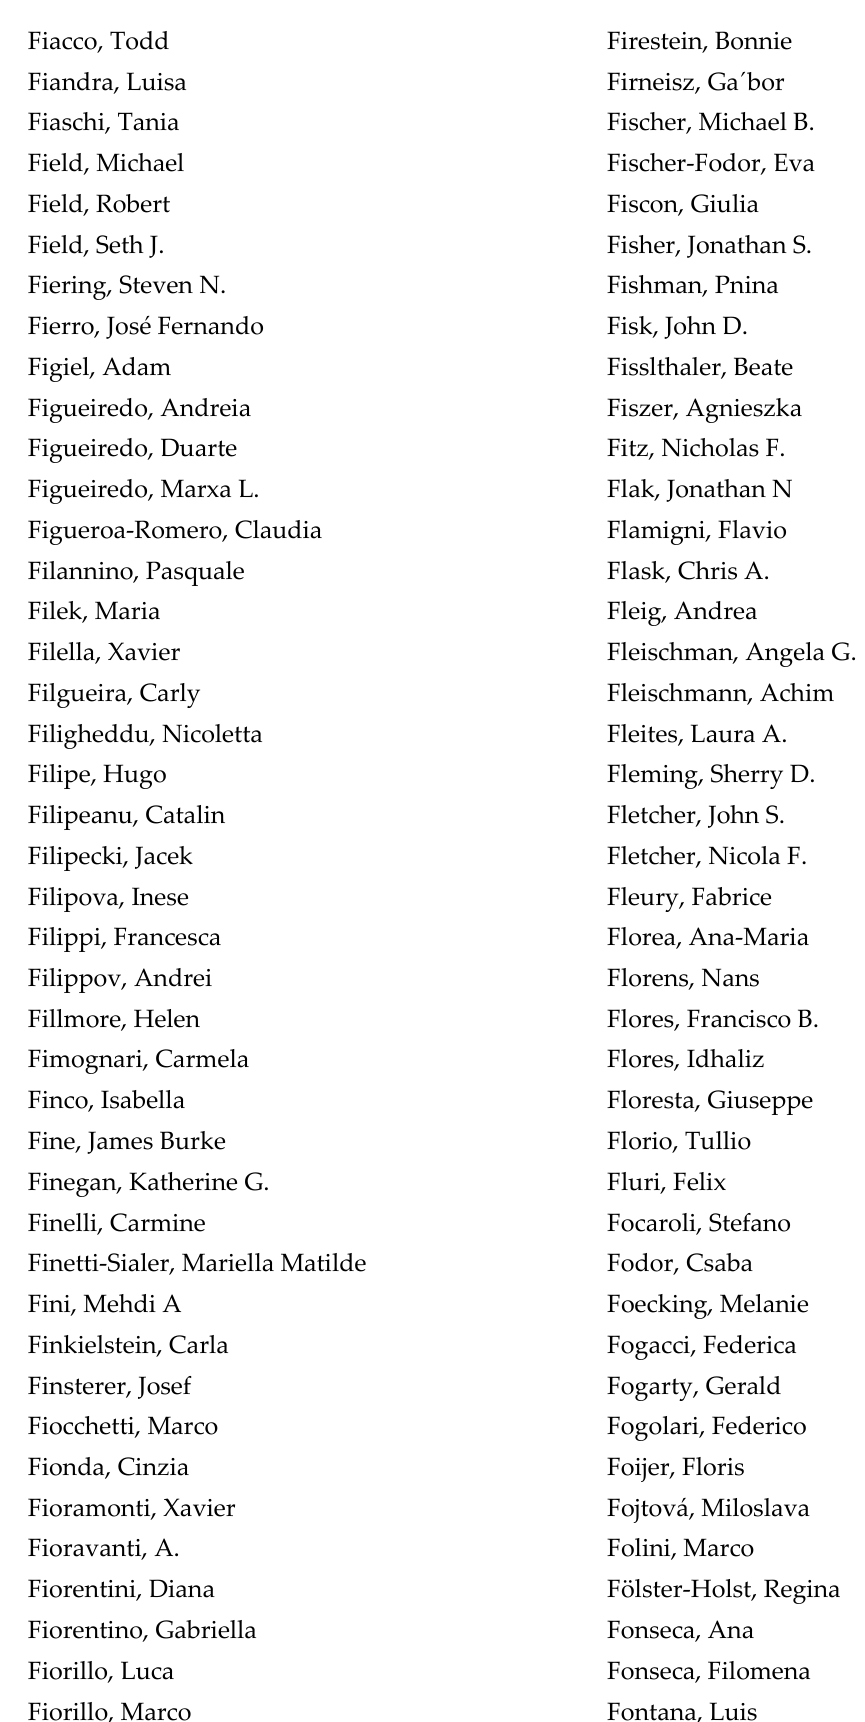
Figiel, Adam Figueiredo, Andreia Figueiredo, Duarte Figueiredo, Marxa L. Figueroa-Romero,